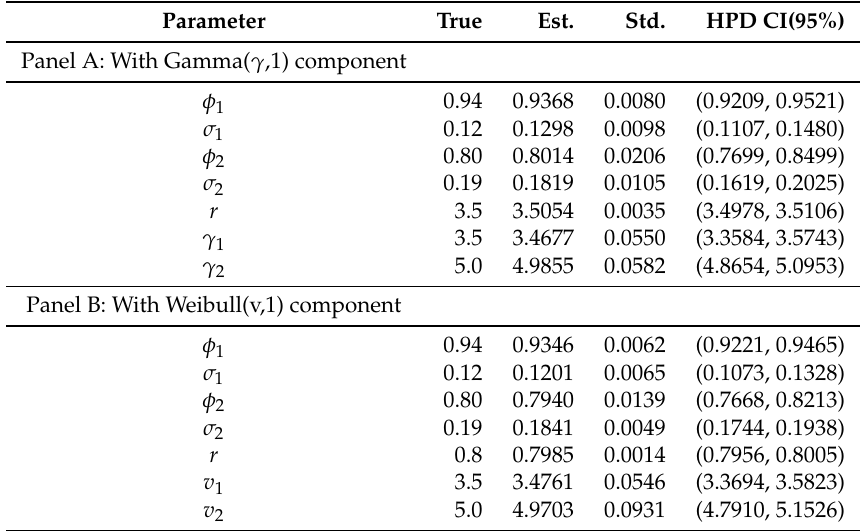
Table 1. True and estimated parameters of the TSCD models based on the simulated duration data.